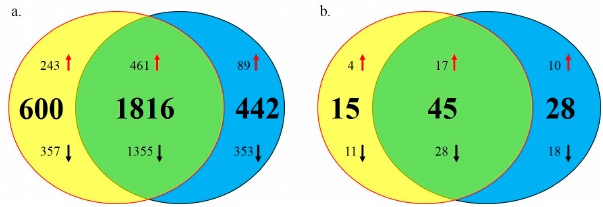
Figure 4. Differentially expressed genes and miRNAs between E14 and 7w. ( a ) Differentially expressed genes between E14 and 7w. The three groups of the Venn diagram represent the normal specific period DEGs (yellow), SLD specific period DEGs (blue), and common period DEGs (green), respectively. The red arrows represent miRNAs that are up-regulated expression between E14 and 7w, and the black arrows represent miRNAs that are down-regulated expression between E14 and 7w; ( b ) differentially expressed miRNAs between E14 and 7w. The three groups of the Venn diagram represent the normal-specific period DEMs (yellow), SLD-specific period DEMs (blue), and common period DEMs (green), respectively. The red arrows represent miRNAs that are up-regulated expression between E14 and 7w, and the black arrows represent miRNAs that are down-regulated expression between E14 and 7w.